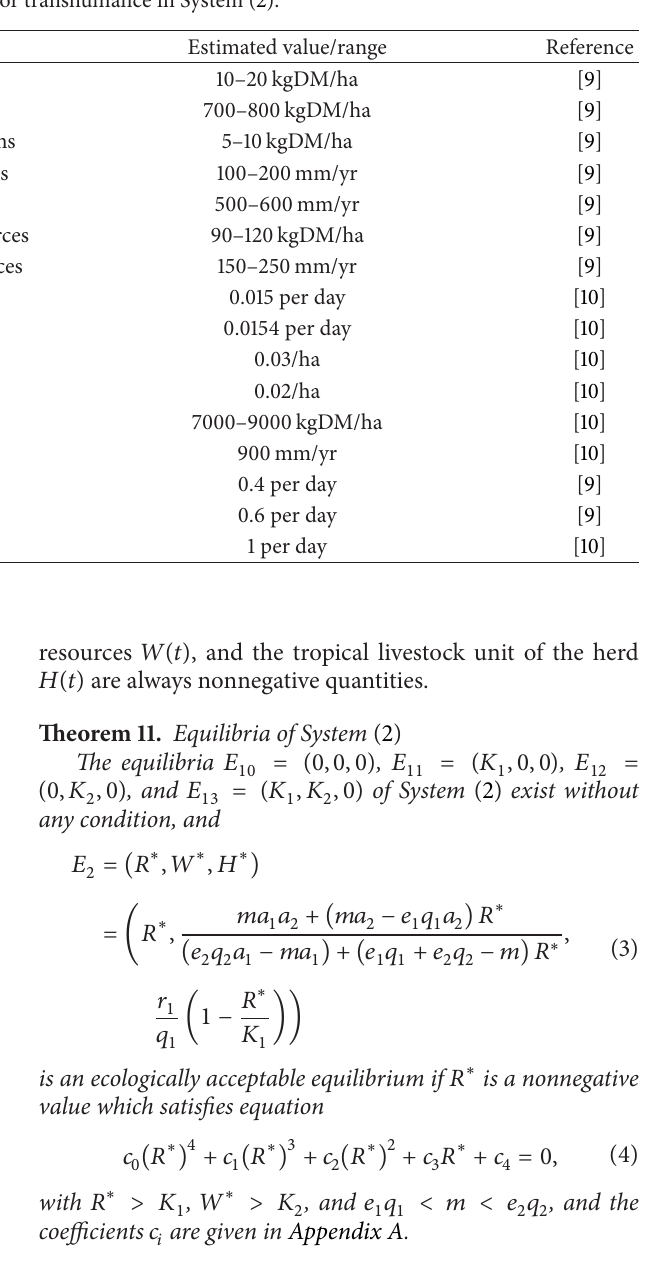
Table 2: Parameter values for transhumance in System